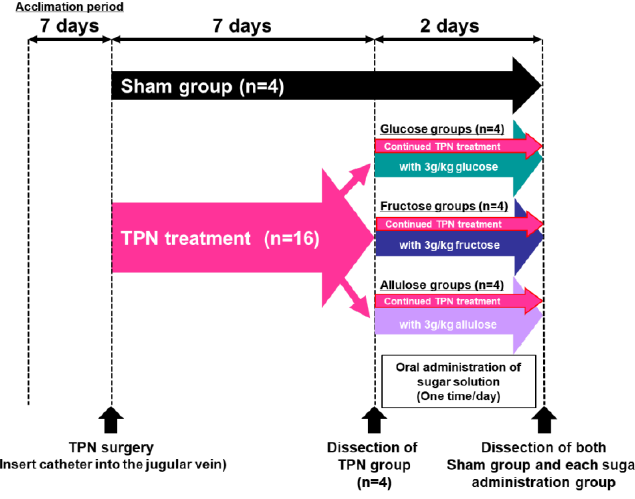
Figure 4. Schematic diagram of TPN study procedure.